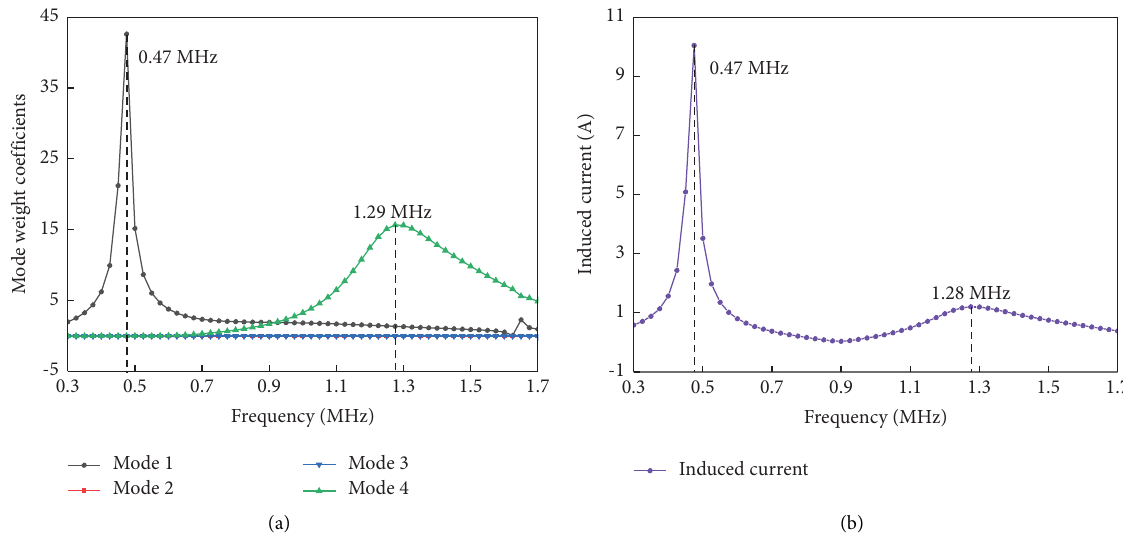
Figure 8: Variation with the frequency of mode weight coefcient and the induced current calculated by MoM. (a) Mode weight coefcients. (b) Te induced current calculated by